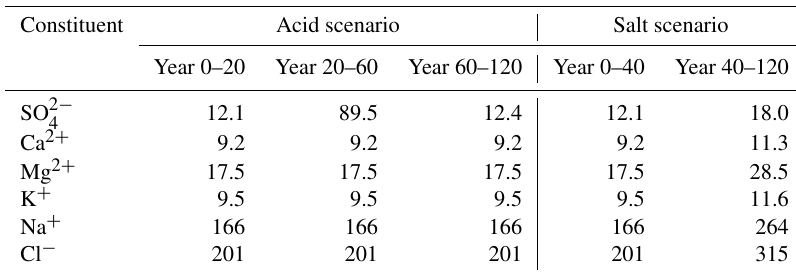
Table 2. Total deposition values used in the scenarios (mmolm − 2 yr − 1